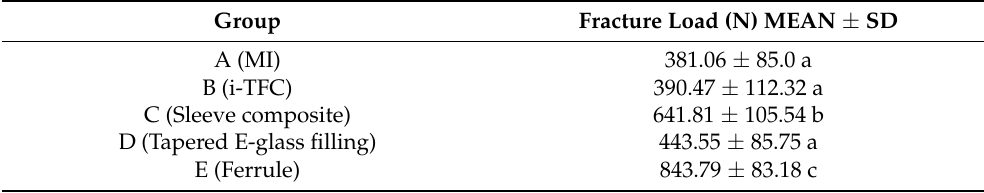
Table 2. Fracture strength of the loading test.